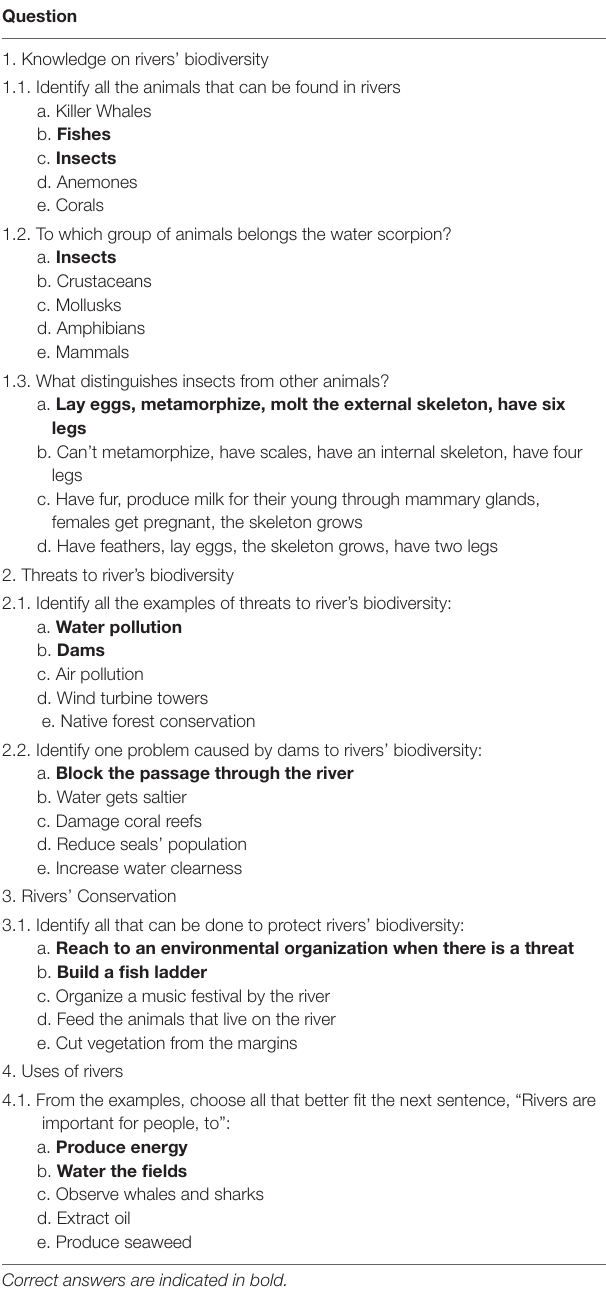
TABLE 1 | List of questions used as pretest and